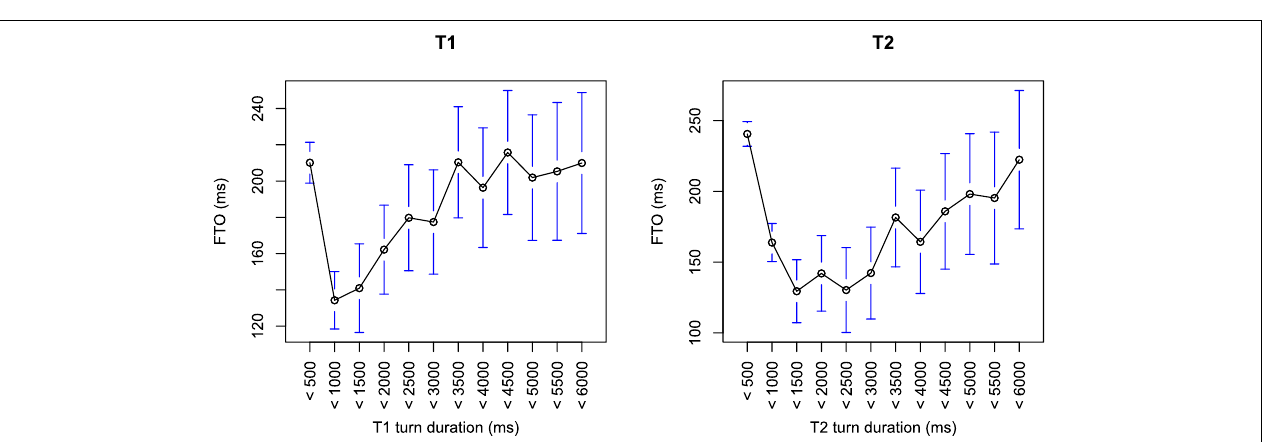
Frontiers in Psychology |